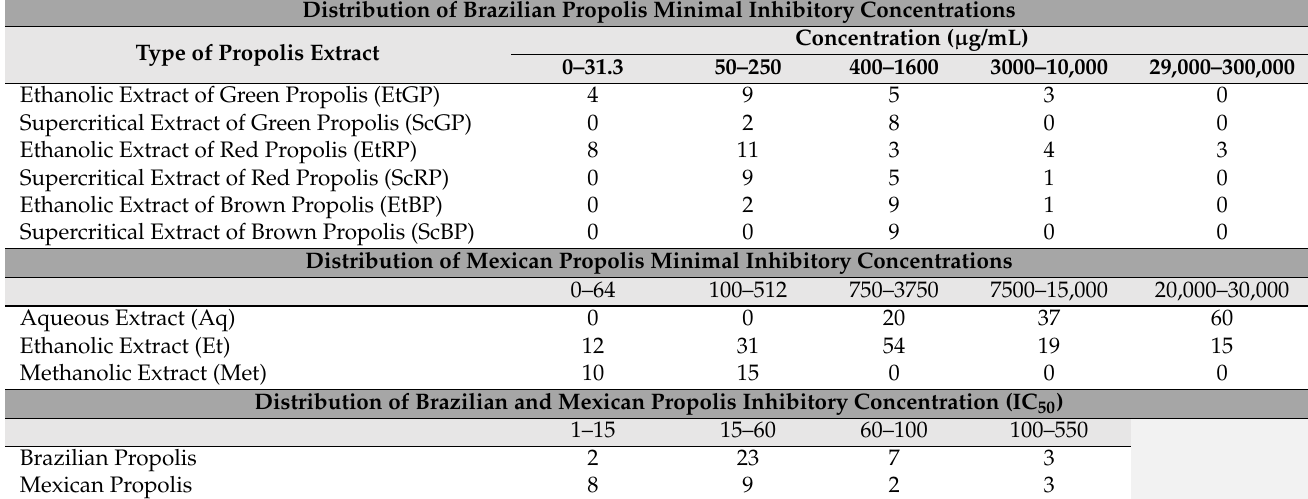
Table 1. Number of occurrences of inhibitory concentrations divided in intervals. Distribution of Brazilian Propolis Minimal Inhibitory